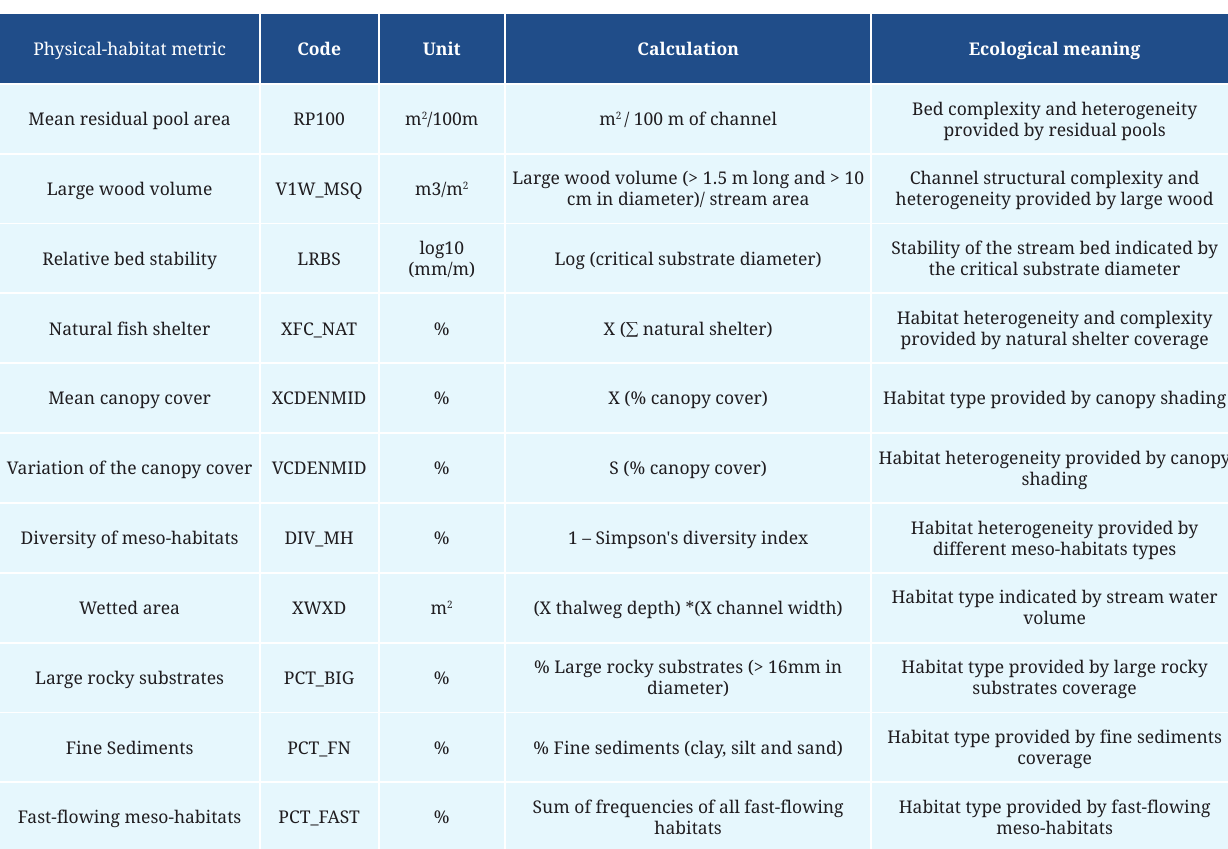
TABLE 1 | The 11 metrics used to describe the physical habitat of streams from the Araguari River basin. Calculation and ecological meaning based on Kaufmann et al . (1999), Hughes, Peck (2008), and Kaufmann, Faustini